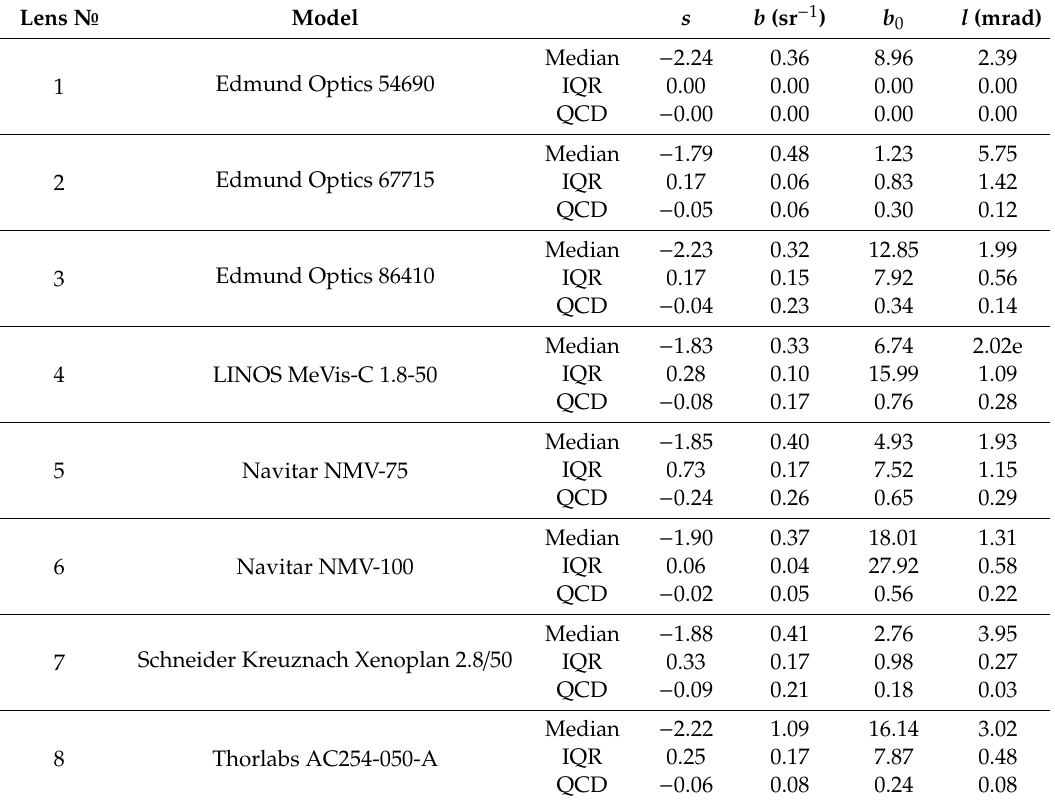
Table 7. Results of the statistical analysis for the scatter parameters s , b , l and b 0 . IQR: interquartile range, QCD: quartile coe ffi cient of